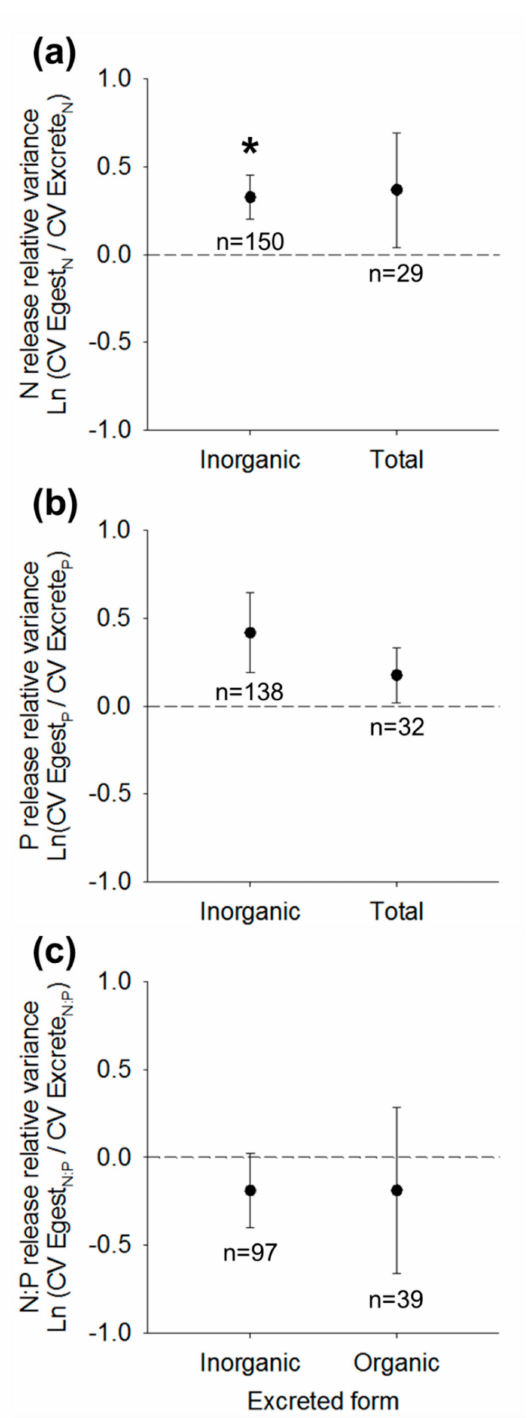
Figure 3. Mean ± SE global intercepts of best-fit weighted mixed e ff ects models predicting ( a ) N relative release variance, ( b ) P relative release variance, or ( c ) N:P relative release variance of egestion compared to excretion. In each panel, means describe relative variance calculated from variance of total nutrient egestion relative to (left) strictly inorganic nutrient excretion or (right) total nutrient excretion. Positive values indicate variance of egestion rates or ratios exceed variance of excretion rates or ratios. Sample sizes n (number of study populations) are designated for each mean and asterisks designate mean intercepts significantly di ff erent from zero (two-tailed t -test; p < 0.05). See Table 3 and Table S2 for associated model